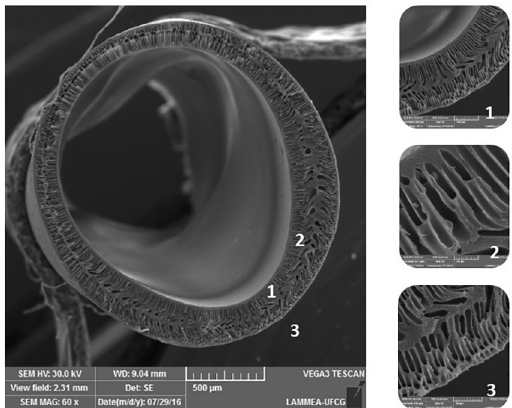
Figure 7 . SEM photomicrographs of PES+3% MMT hollow fiber membrane.